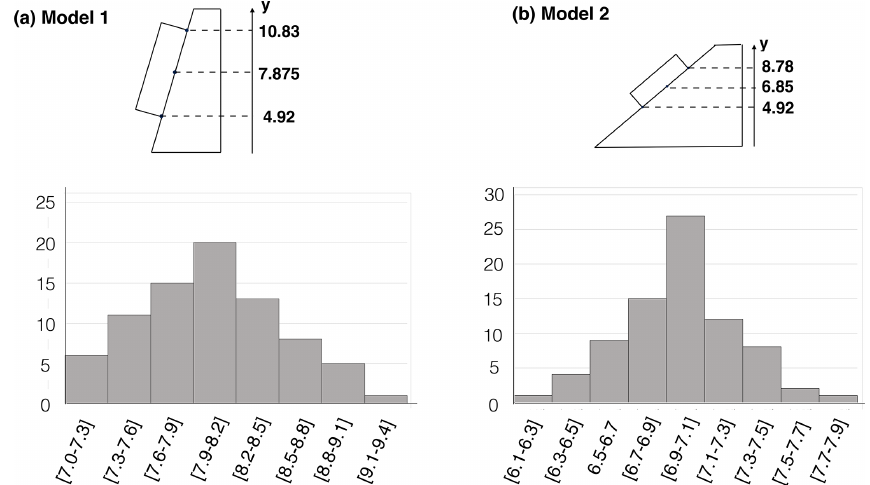
Figure 9. Histogram of the average altitude ( y coordinate) of the OC contacts, for models 1 and 2 considering Scenario 3 (run two times). N is equal to 18 and 46 for model 1 and 2 respectively.